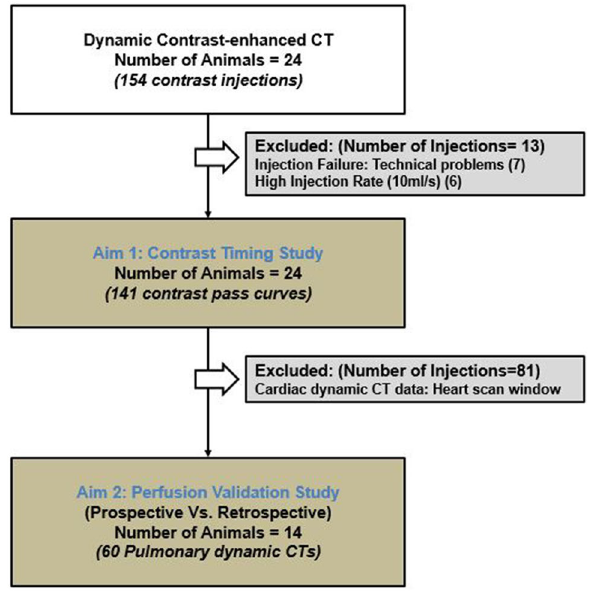
Figure 1. Flowchart of the study. A total of 141 successful contrast injections were used in the Aim1 study in investigate the optimal acquisition time of the maximal contrast enhancement in pulmonary artery. A total of 60 pulmonary CT acquisitions were used in the prospective two-volume perfusion validation